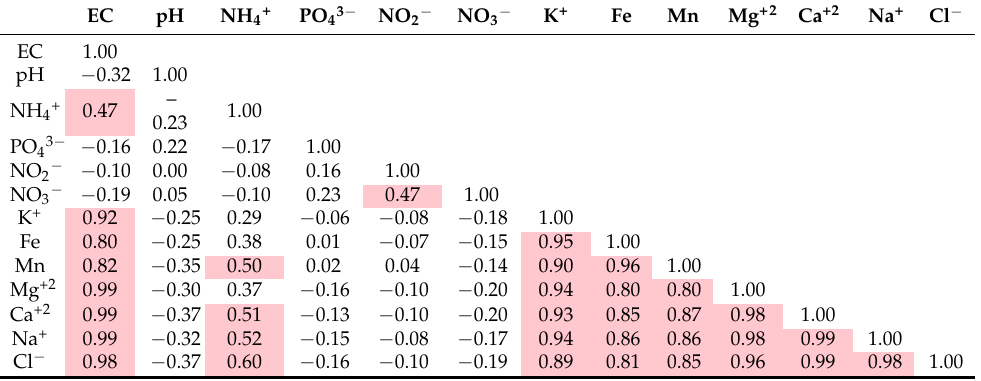
Table 4. Pearson correlations between the water parameters: EC, pH, NH 4+ , PO 43 − , NO 2 − , NO 3 − , K + , Fe, Mn, Mg +2 , Ca +2 , Na + , and Cl − . Data in red correspond to p < 0.05. EC pH NH 4+ PO 43 − NO 2 − NO 3 − K